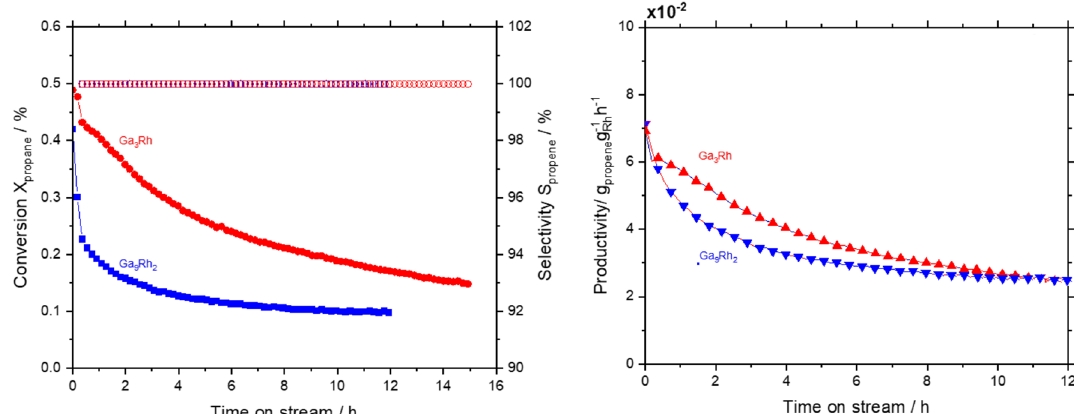
Figure 3. Continuous gas-phase propane dehydrogenation using GaRh IMC catalysts. For Ga 3 Rh (red symbols) and Ga 9 Rh 2 (blue symbols) the conversion (filled) and selectivity (open) are shown over the time on stream in the right figure. The left figure shows productivities i.e. the mass of propene produced per mass of Rh.